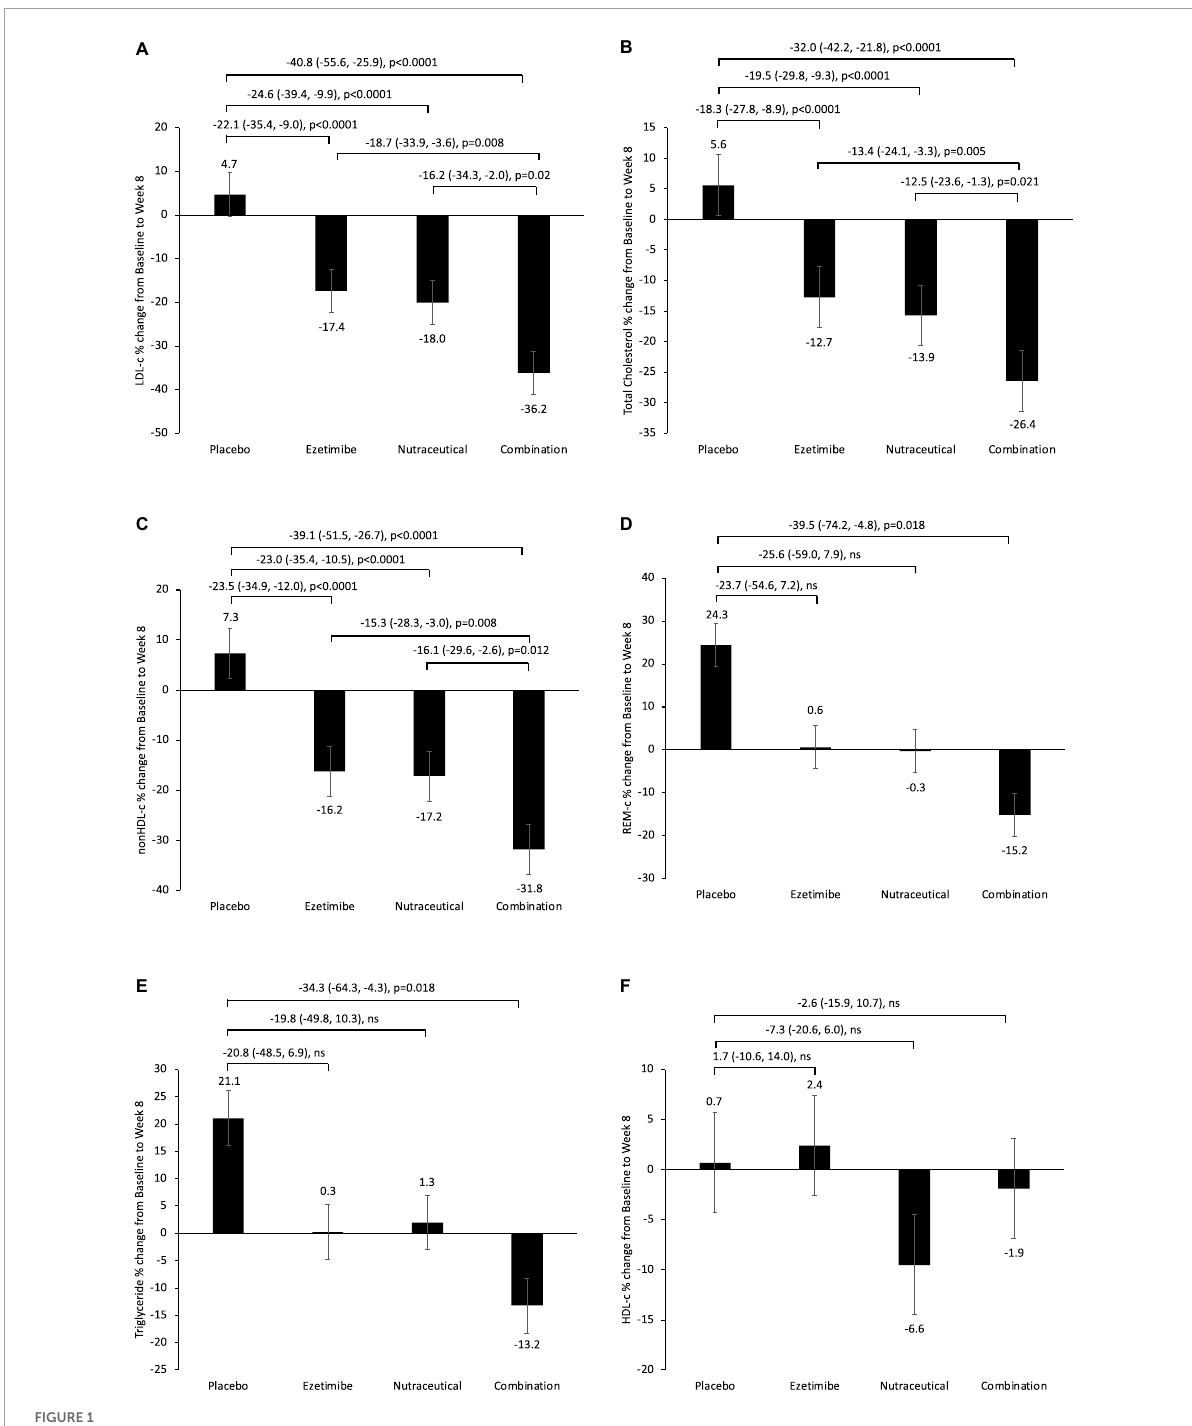
FIGURE1 Percentage change from baseline in fasting plasma (A) LDL-c, (B) total cholesterol, (C) non-HDL-c, (D) REM-c, (E) triglycerides and (F) HDL-c, following 8-week treatment with placebo, ezetimibe, nutraceutical regimen, or combination. Intergroup comparisons via univariate ANOVA with Bonferroni post-host